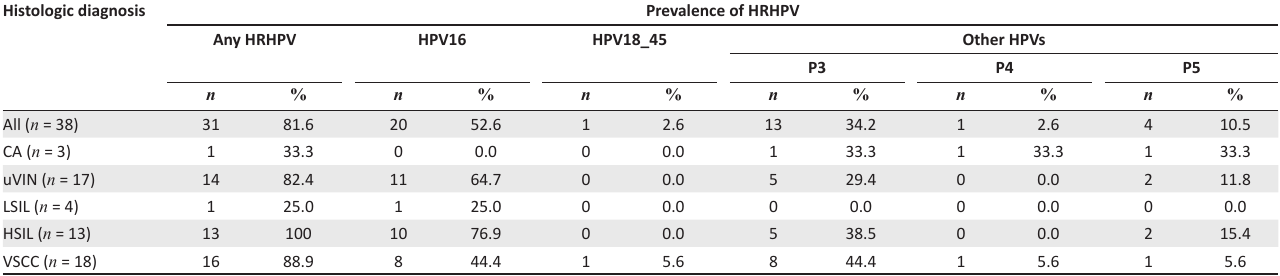
TABLE 2: Prevalence of high-risk human papillomavirus among women with condyloma acuminatum, uVIN (LSIL, HSIL) and VSCC at the University Teaching Hospital’s gynaecologic clinic, Zambia, 2018. Histologic diagnosis Prevalence of HRHPV